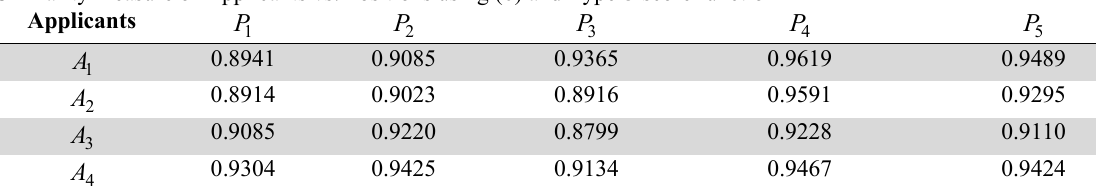
Similarity measure of Applicants vs. Positions using (6) and Type-3 score function